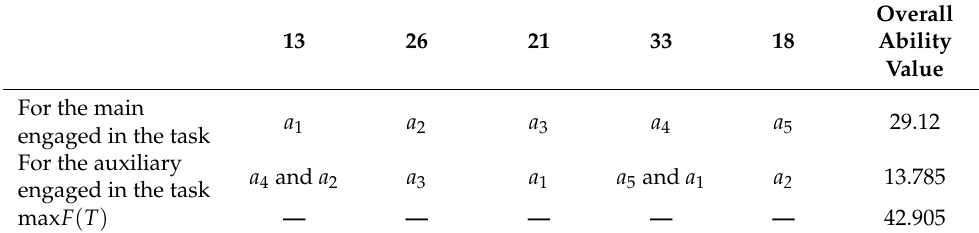
Table 5. Task arrangement and performance of team T = ( 13,26,21,33,18 )